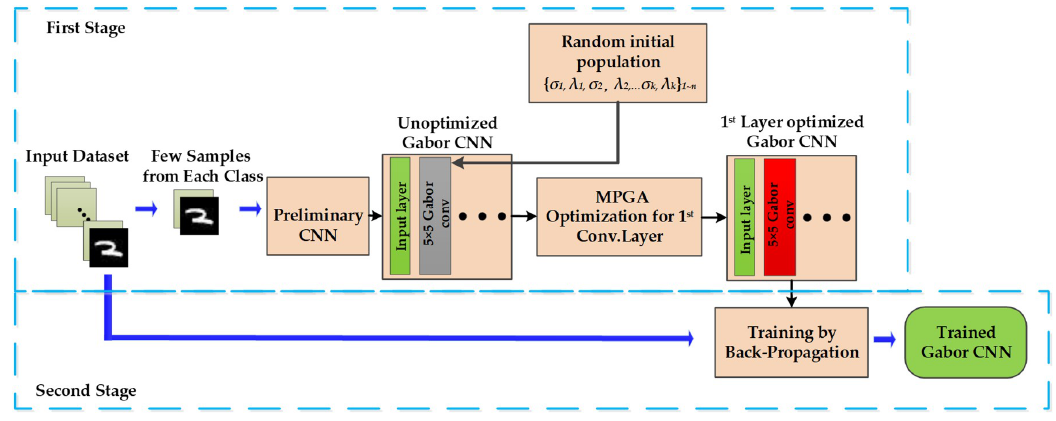
Figure 8. Fast training method for Gabor CNNs.